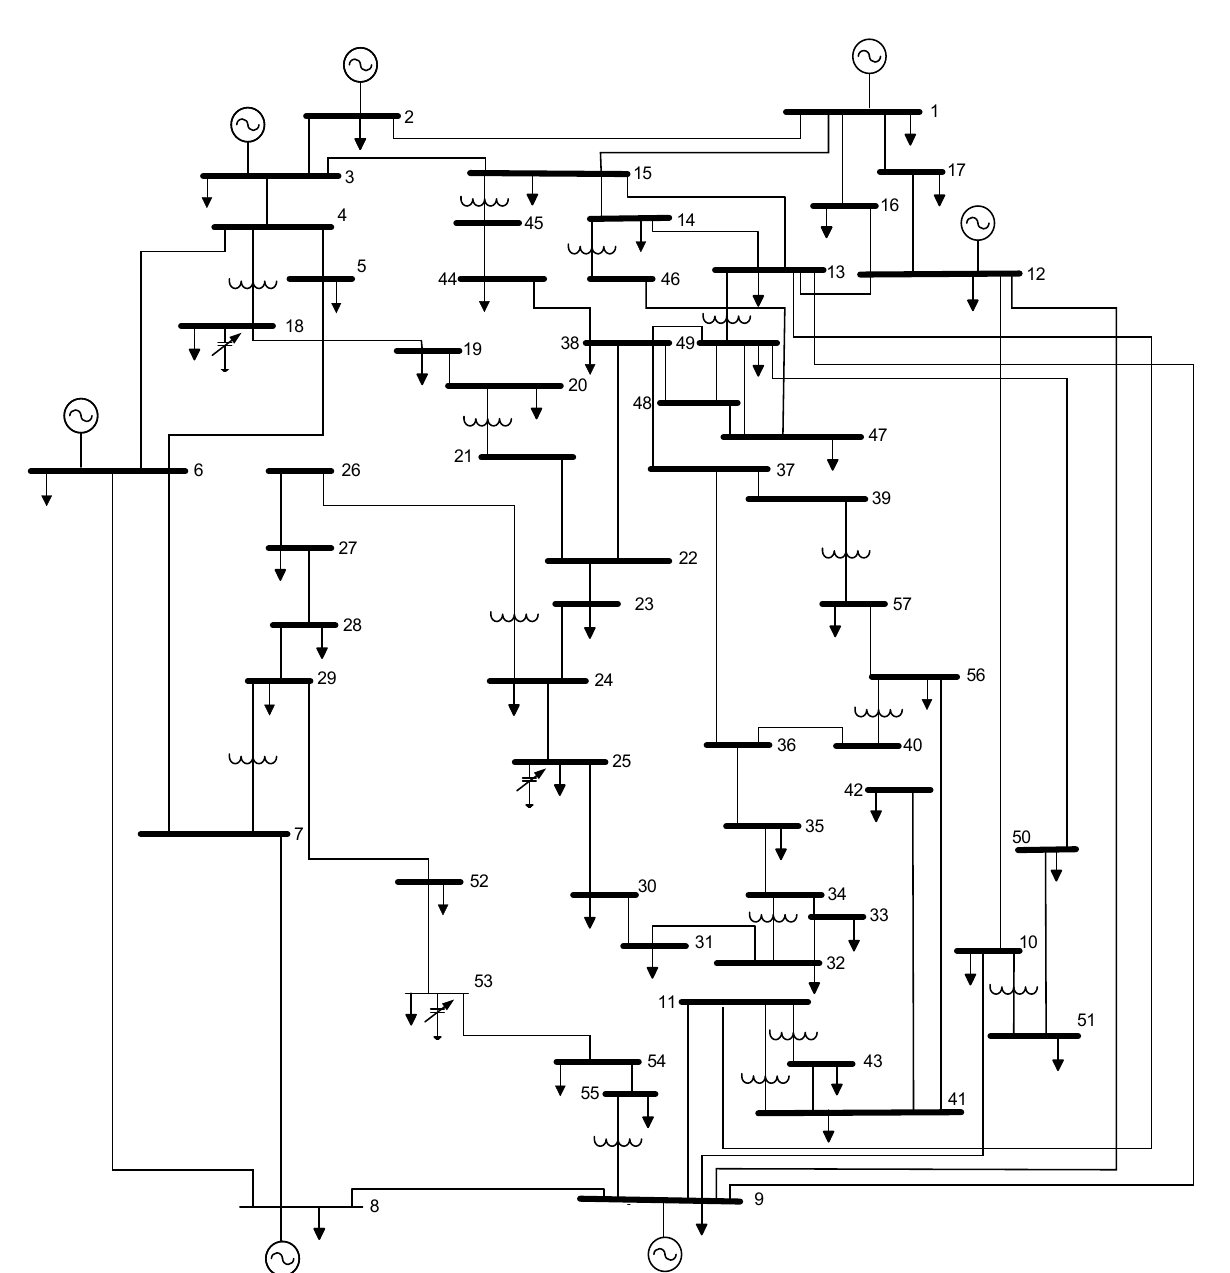
Figure 4. Single line diagram of IEEE 57-bus test system. Table 13. Optimal control variables of IEEE 57-bus test system for Case